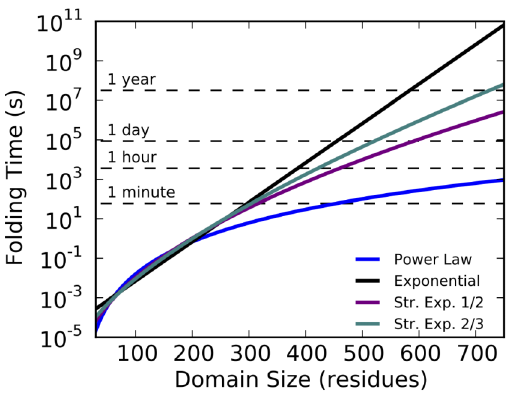
Figure 3. The predicted folding times from each model in Figure 2, in a direct comparison. Intuitive timescales are denoted for clarity.